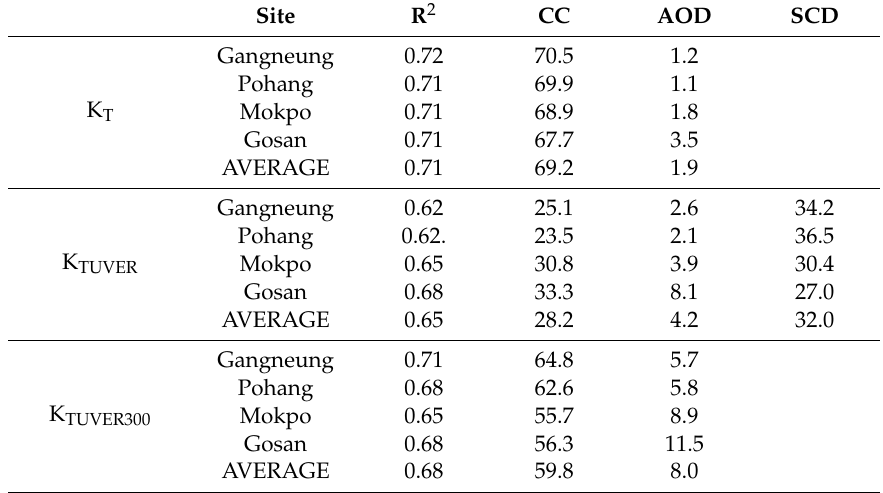
Table 3. Determination coe ffi cients (R 2 ) and individual contributions (%) of each attenuating factor determined by multiple linear regression (MLR) analysis at each